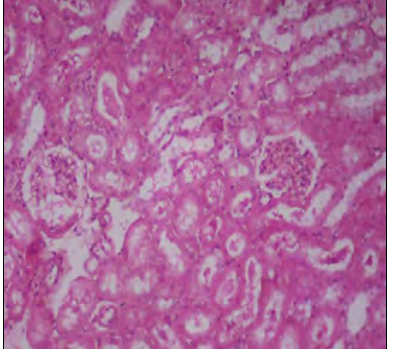
Figure-1. Photomicrograph of kidney showing dilated, ruptured tubules, mild to severe fatty change, reduced glomerular space and with few ruptured glomeruli. H&E X200 (Group 3)